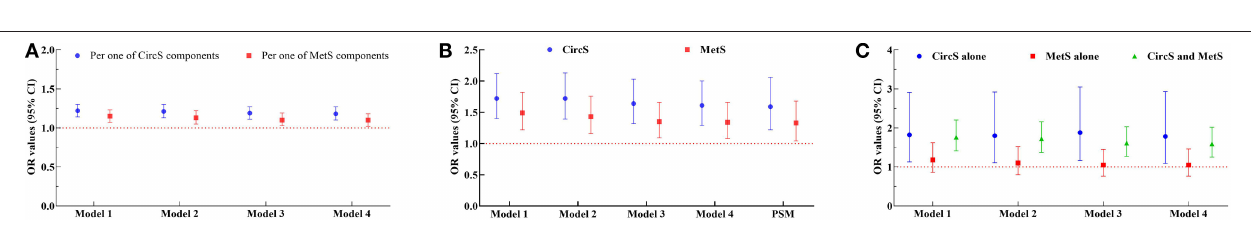
FIGURE 2 | Disparities in the prevalence of stroke, anemia, and chronic kidney disease in the four groups. (A) showed the disparities in the prevalence of stroke. (B) displayed the disparities in the prevalence of anemia. (C) presented the disparities in the prevalence of chronic kidney diseases. Fisher’s precision probability test was adopted to test the differences. Furthermore, multiple comparisons between the four groups were adjusted by the Bonferroni method. MetS, metabolic syndrome; CircS, circadian syndrome; CKD, chronic kidney disease. * P < 0.05; ** P < 0.01; *** P < 0.001.